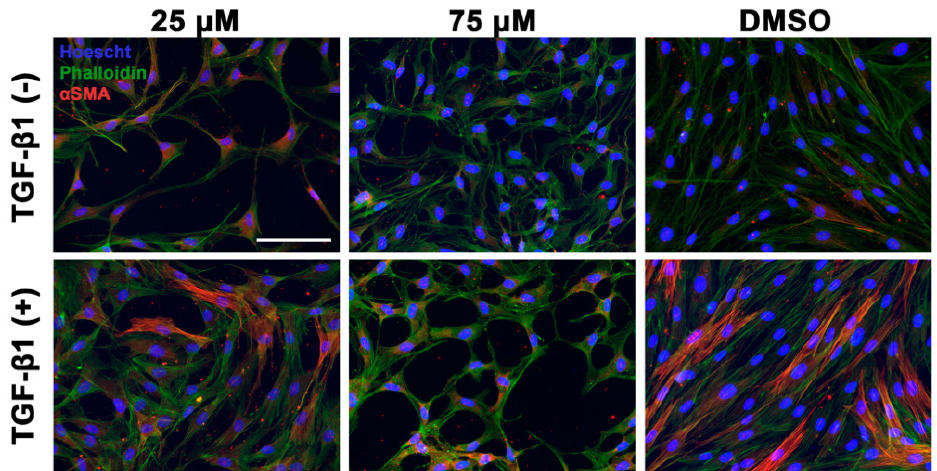
Figure 3. Immunofluorescence confirms a dose − dependent decrease in the upregulation of α SMA with immunofluorescent imaging. Primary rabbit corneal fibroblasts (RCFs) were treated with andrographolide (25 and 75 µ M) or vehicle control (DMSO) in the presence or absence of TGF- β 1 (10 ng/mL). RCFs treated with TGF- β 1 resulted in increased stress fiber formation, F-actin (phalloidin), and α SMA expression. RCFs treated with andrographolide (25 µ M and 75 µ M) showed a decreased expression of α SMA with the 75 µ M having a more pronounced effect. Images selected were representative of the overall immunofluorescence patterns associated with specific treatments. Hoescht nuclear stain in blue, phalloidin (F-actin) in green, α SMA in red. Scale bar equivalent to 100 µ